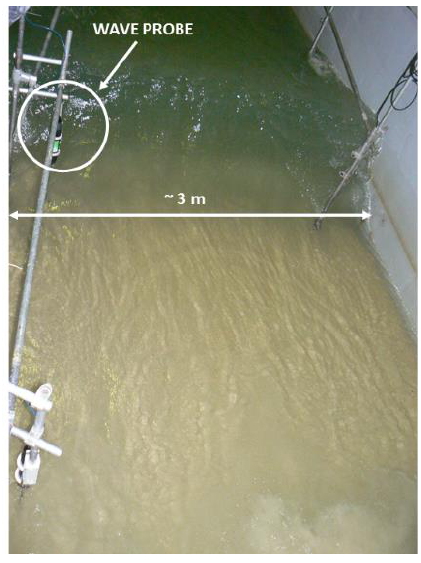
Figure 3. View of the HR Wallingford Wave Probe Monitor used as a reference system during the experiment (encircled on the left-hand